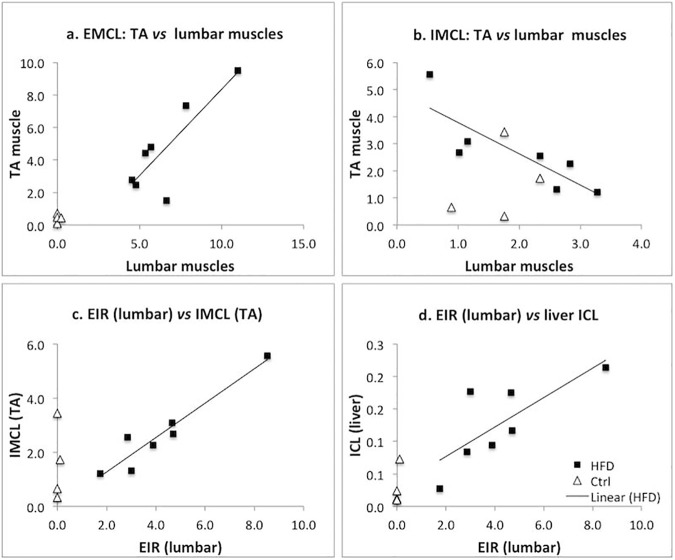
Correlations between anatomically distant fat depots.(a) EMCL in HFD mice are highly correlated (r = 0.84, p = 0.01) between TA and lumbar muscles (squares). (b) The smaller depot of IMCL is negatively correlated between muscle types in HFD (r = -0.84, p = 0.01). (c) TA IMCL is correlated with the ratio of EMCL to IMCL (EIR) (r = 0.96, p<0.001, and (d) liver ICL (r = 0.77, p = 0.03) fat is correlated with lumbar EIR. Data for control mice are shown in triangles.